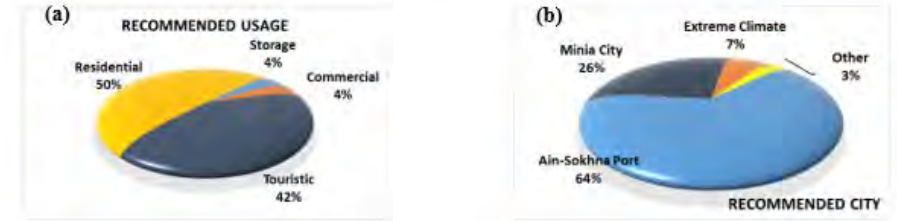
Figure 5. The recommended city and usage for the Earth-sheltered buildings by Egyptian